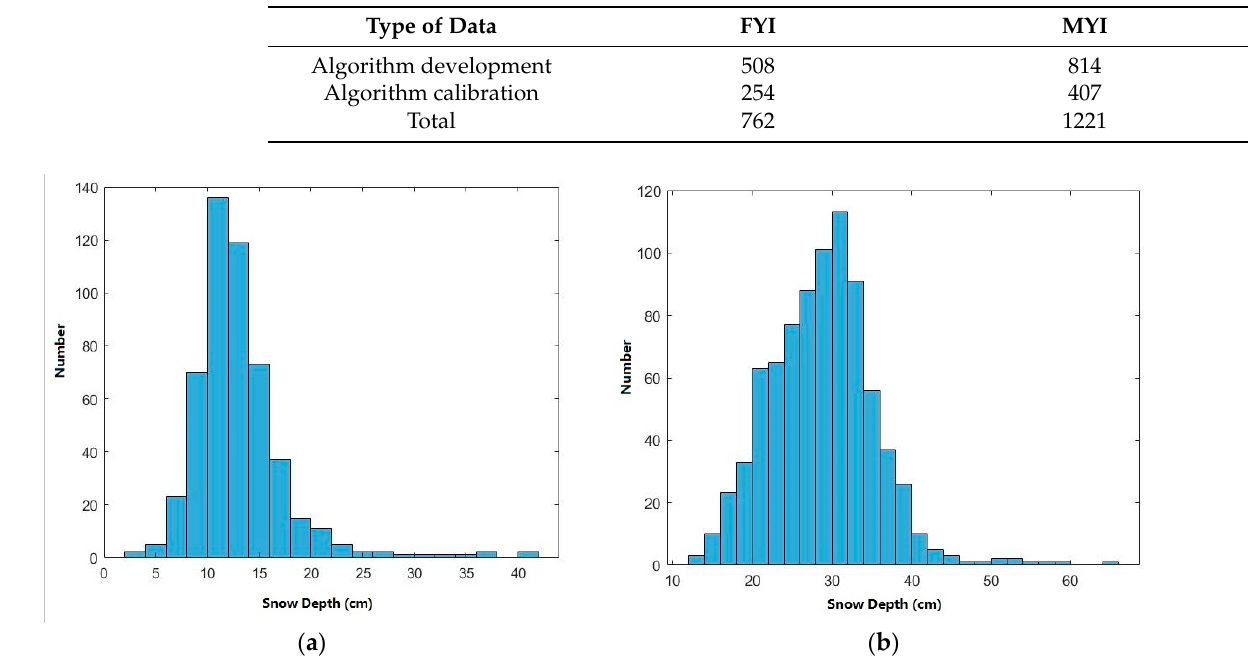
Table 4. The amount of snow depth data for algorithm development and verification.